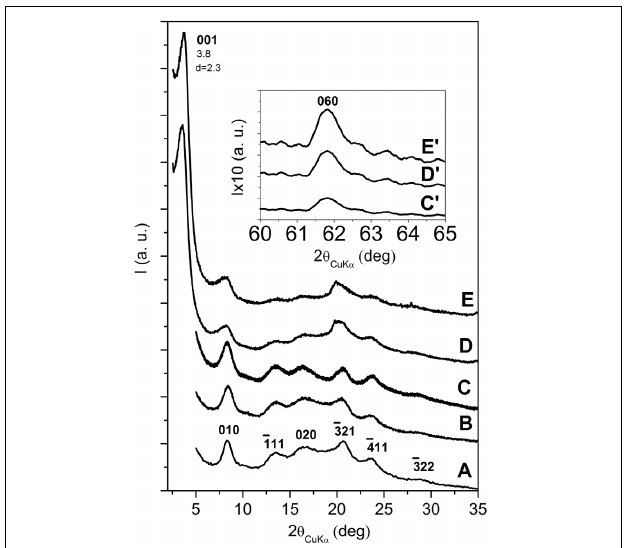
FIGURE 4 | X-ray diffraction (CuK α ) patterns in the 2 ϑ range 2–35 ◦ of s-PS aerogels with as received OMMT, as obtained from gels with a solvent content of 90 wt % and presenting different polymer/OMMT weight ratios: (A) 100/0; (B) 96/4; (C) 92/8; (D) 80/20; (E) 50/50. The insets C (cid:4) , D (cid:4) and E (cid:4) enlarge the 060 in-plane reflection of the clay. The Miller indexes of the main reflections of the nanoporous-crystalline δ form of s-PS are indicated in (A) .